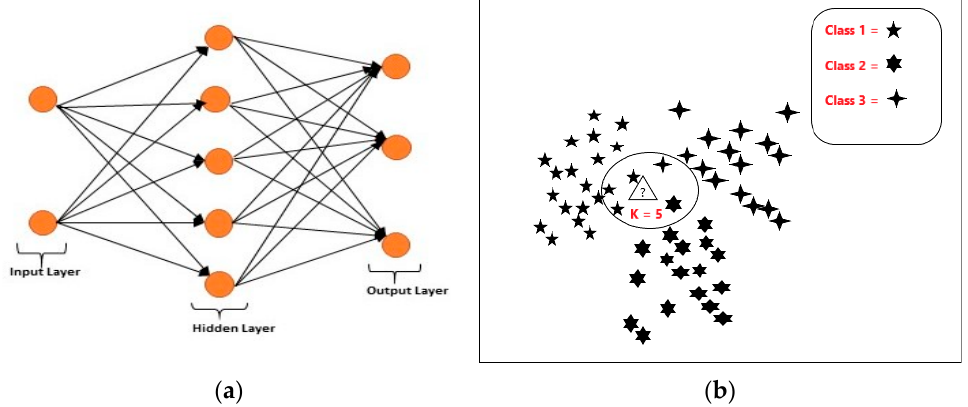
Figure 13. Structure and illustration of applied models: ( a ) ANN; ( b ) KNN.